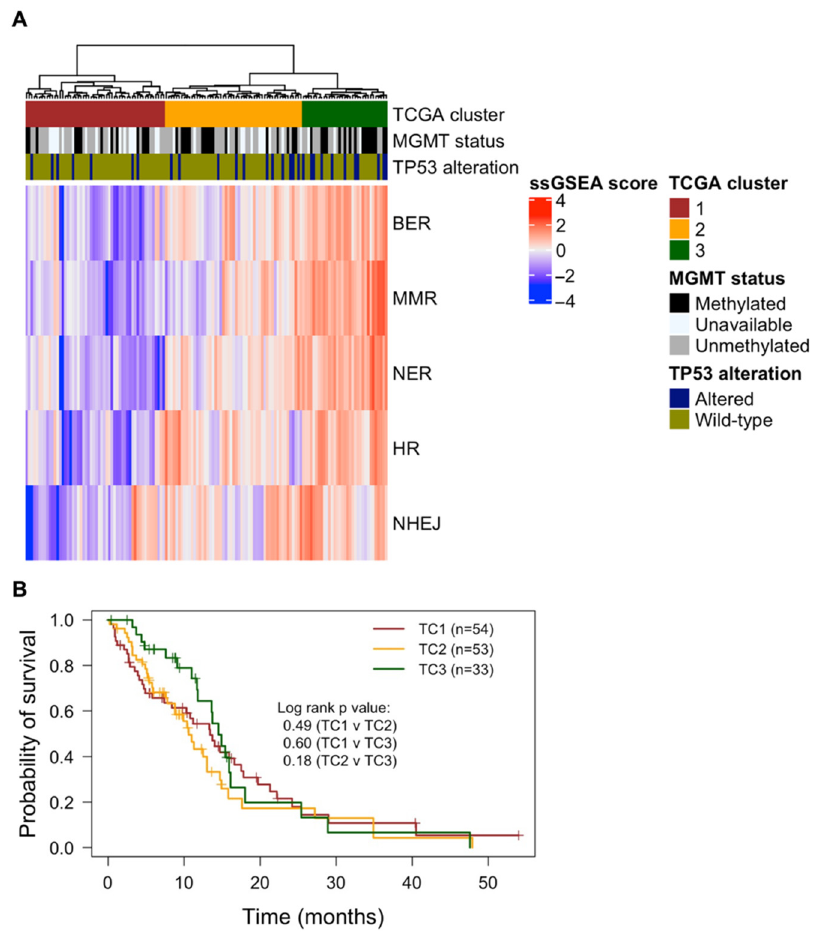
Figure 1. Transcriptomic profile of DDR pathways of glioblastoma patients in the TCGA cohort ( n = 140). ( A ) Log-transformed ssGSEA scores are represented for each DDR pathway; and after hierarchical clustering (Ward’s method), three distinct TCGA clusters were identified (TC1, TC2,